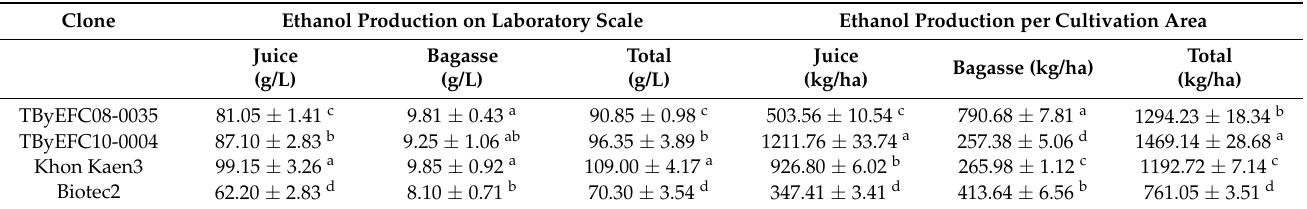
Table 6. Ethanol production on laboratory scale and agronomic scale from juice and bagasse of energy cane clones and control